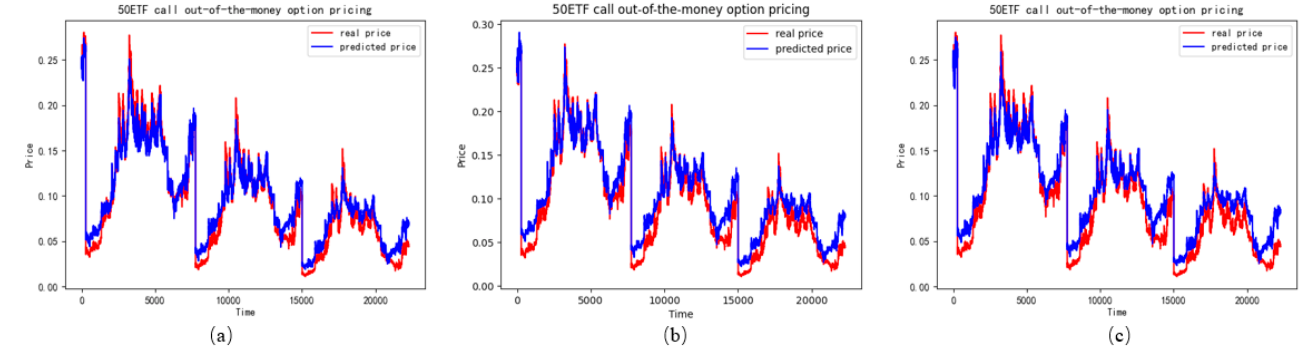
Figure 8. The performance of ATM call options in different features ( a ) represents the LSTM with realized skewness, ( b ) represents the LSTM without realized skewness, ( c ) represents the LSTM with realized skewness and realized kurtosis.